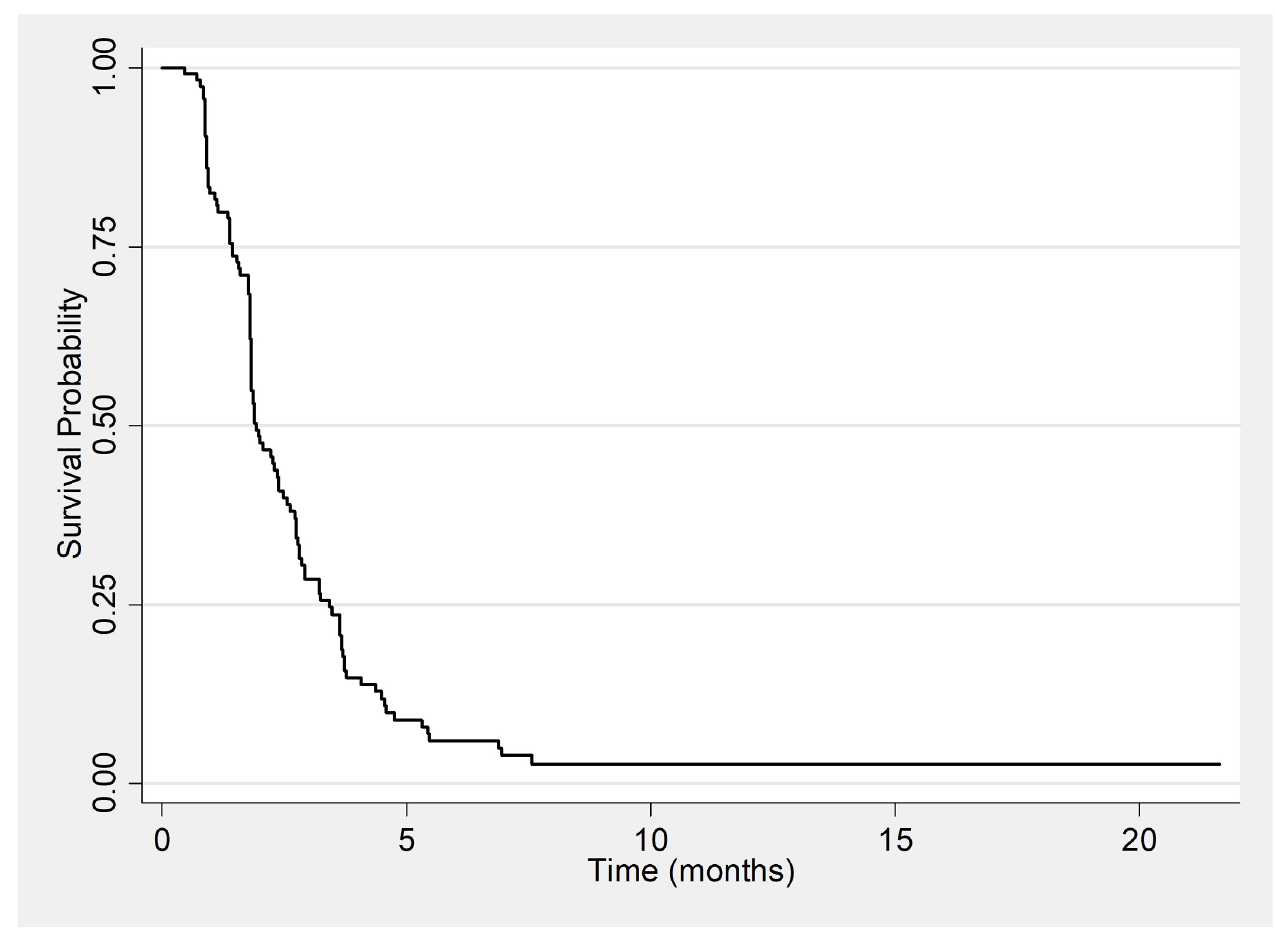
Fig 5. Kaplan-Meier time to culture conversion whole